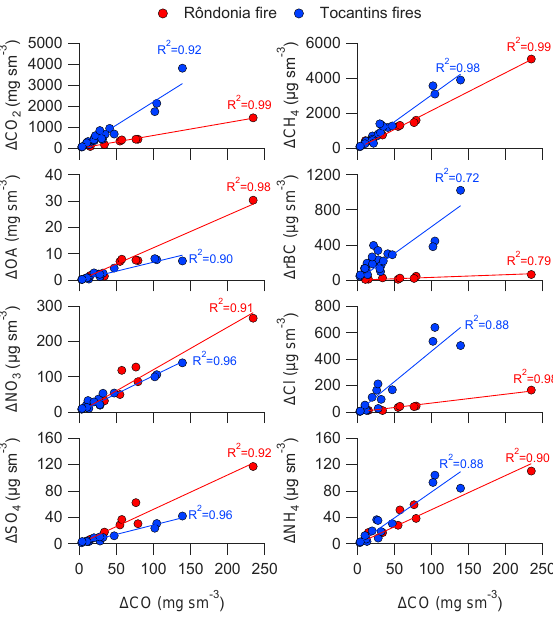
Figure 2. Relationship between excess concentrations of trace gas and particulate-phase species relative to excess carbon monoxide for the Rondônia and Tocantins fires. Solid lines show line of best fit from linear regressions forced through